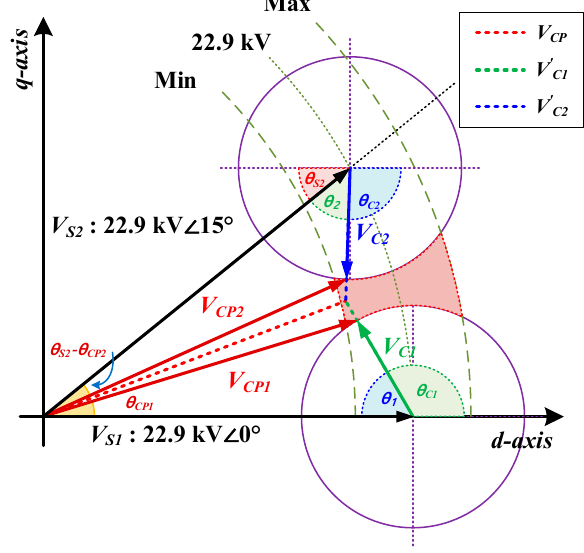
Figure 9. Parameter extraction for calculation of V CP1 and V CP2 .